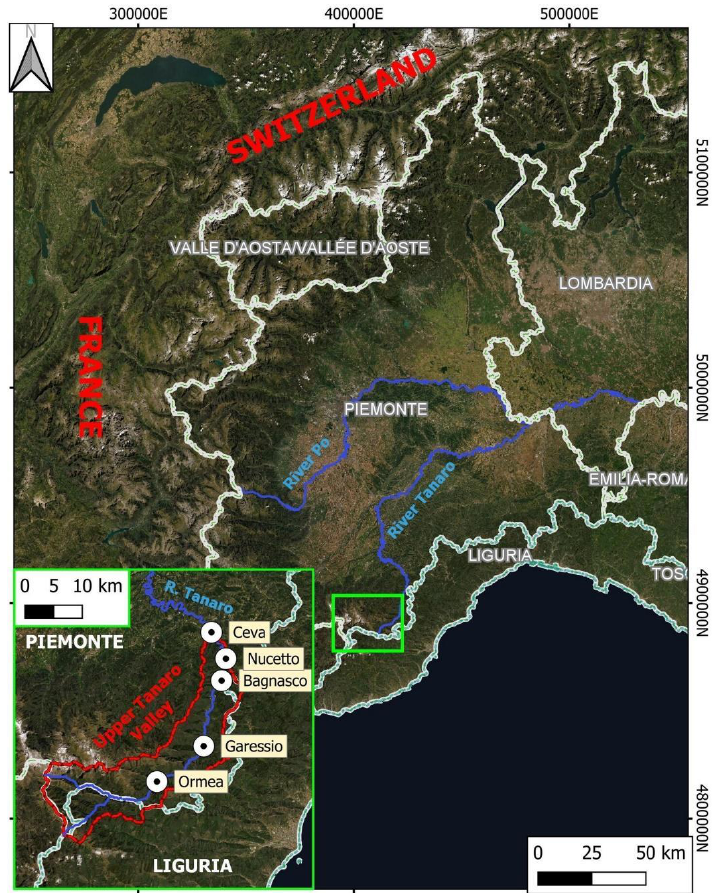
Figure 2. Geographical setting of the study area (green rectangle), located in NW Italy.